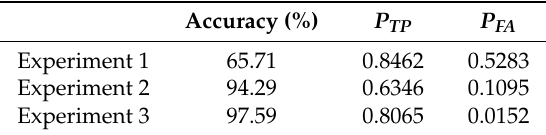
Table 3. Classification results for the first dataset (Experiments 1–3).